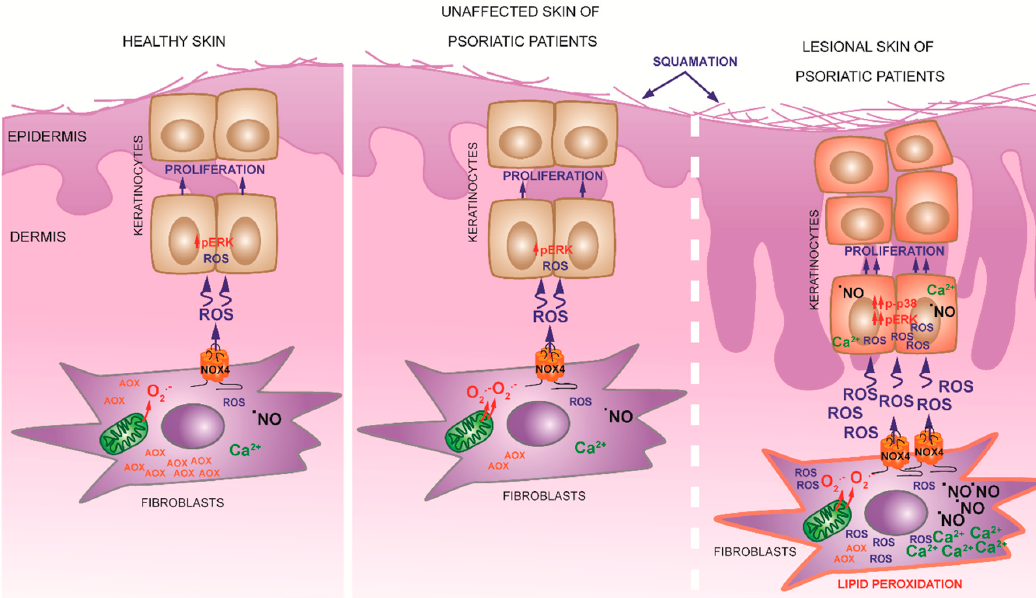
Figure 6. Schematic representation of the proposed mechanism of NOX4 contribution in psoriatic plaque formation. Healthy primary fibroblasts, as well as fibroblasts obtained from visibly una ff ected skin of psoriatic patients, activate ERK1 / 2, increase intracellular total ROS level and accelerate cell cycle progression in healthy primary keratinocytes in co-culture through the redox signalling mediated by NOX4. Fibroblasts obtained from una ff ected and lesional skin of psoriatic patients di ff er from healthy fibroblasts by elevated mitochondrial superoxide anion production and decreased total antioxidant capacity. Moreover, lesional fibroblasts display significantly higher levels of intracellular • NO, Ca 2 + and lipid peroxidation as well as elevated NOX4 activity and extracellular ROS production. Lesional fibroblasts induce significantly higher levels of intracellular ROS and ERK activation in healthy keratinocytes with respect to healthy and una ff ected psoriatic fibroblasts. Moreover, co-culture with lesional fibroblasts induced • NO and Ca 2 + accumulation in keratinocytes and significant activation of p38 molecular pathway. The result of these metabolic alterations is keratinocytes hyper-proliferation. Hence, dermal fibroblasts may trigger keratinocytes